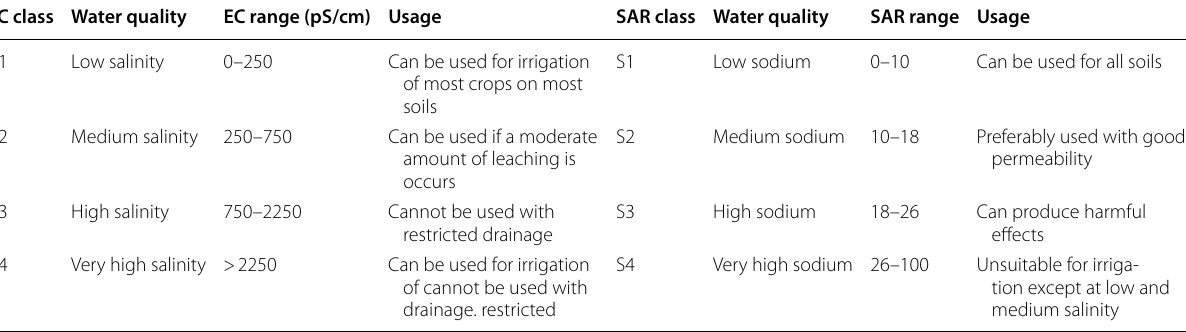
Table 11 Water quality for irrigation according to College of Agricultural Sciences (2002) and U.S. Salinity Laboratory Staff (1954)